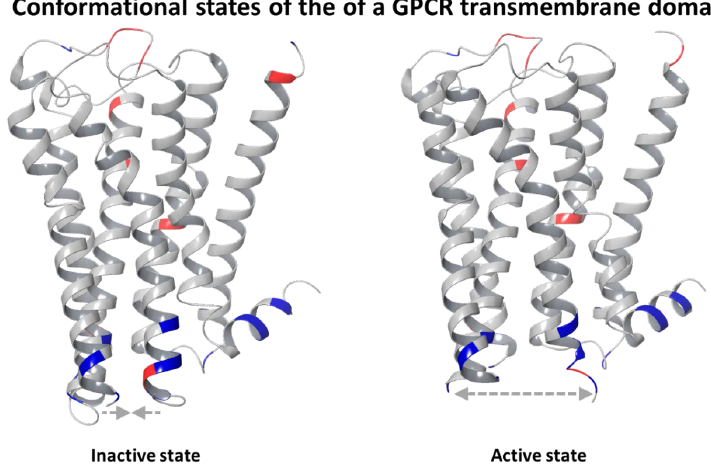
Figure 7. Schematic diagram illustrating the conformational change of rat OR-17 that was used to monitor ligand presented in